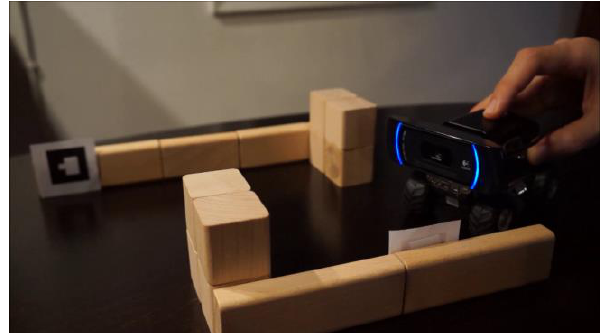
Figure 4. Image of the experimental setup. The camera is mounted on a hand-controlled RC car navigating through a corridor with obstacles built with blocks. The camera is attached to the computer running the application and the RC car is moved manually for the tests. The markers are placed on the corridors and obstacles.